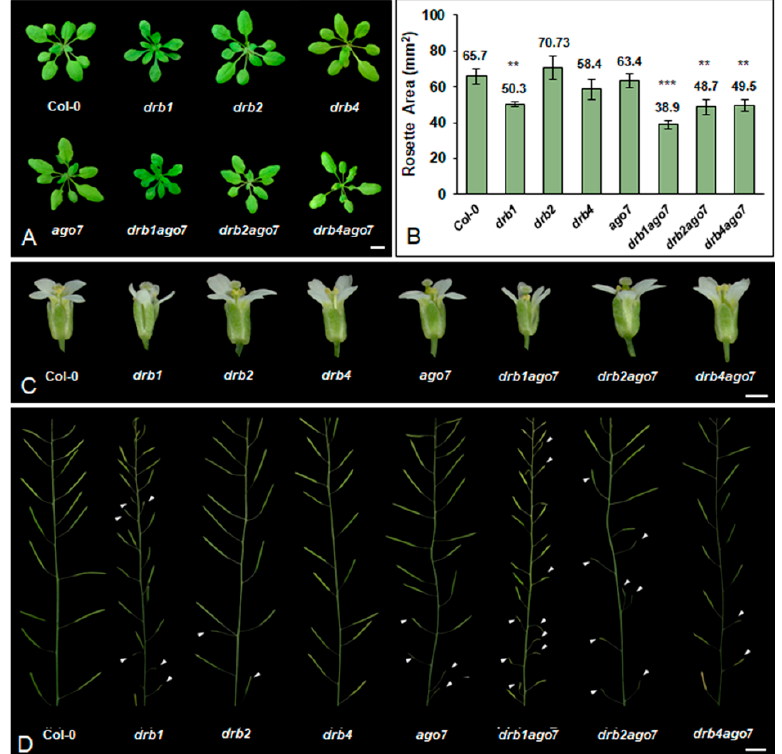
Figure 1. The vegetative and reproductive phenotypes displayed by the single or double mutant plant lines analyzed in this study. ( A ) the rosette phenotype displayed by 28-day old Col-0 plants and the drb1 , drb2 , drb4 , ago7 , drb1ago7 , drb2ago7 , and drb4ago7 mutants. Scale bar = 10 mm; ( B ) quantification of the rosette area of 28-day old Col-0, drb1 , drb2 , drb4 , ago7 , drb1ago7 , drb2ago7, and drb4ago7 plants. The presence of an asterisk above a column represents a statistically significant di ff erence between the mutant plant line and Col-0 plants ( p -value: ** < 0.005; *** < 0.001); ( C ) an open flower sampled from the terminal floral bud of the primary inflorescence of 42-day old Col-0, drb1 , drb2 , drb4 , ago7 , drb1ago7 , drb2ago7 , and drb4ago7 plants. Scale bar = 1.0 mm; ( D ) silique development along the length of the primary inflorescence of 42-day old Col-0, drb1 , drb2 , drb4 , ago7 , drb1ago7 , drb2ago7 , and drb4ago7 plants. Scale bar = 10